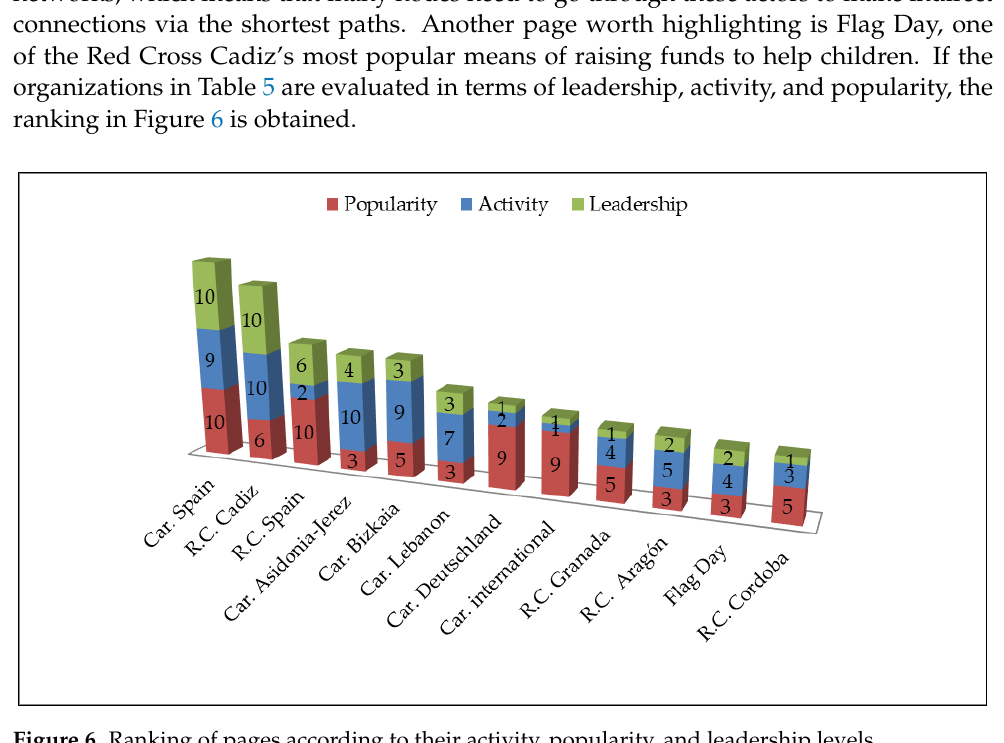
Pages. Table 5. Pages with the highest level of intermediation. Pages.